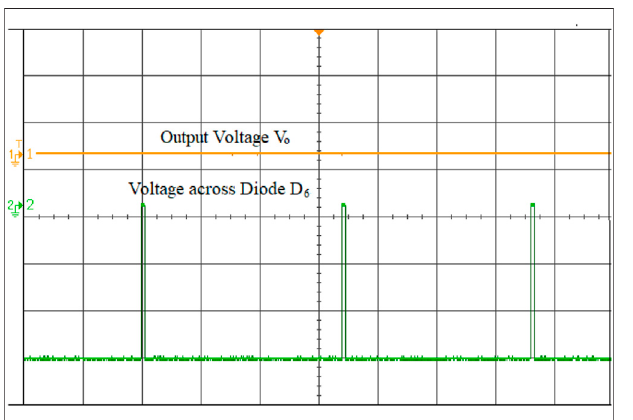
FIGURE 17 | Output Voltage Vo and Diode Voltage D 6 .